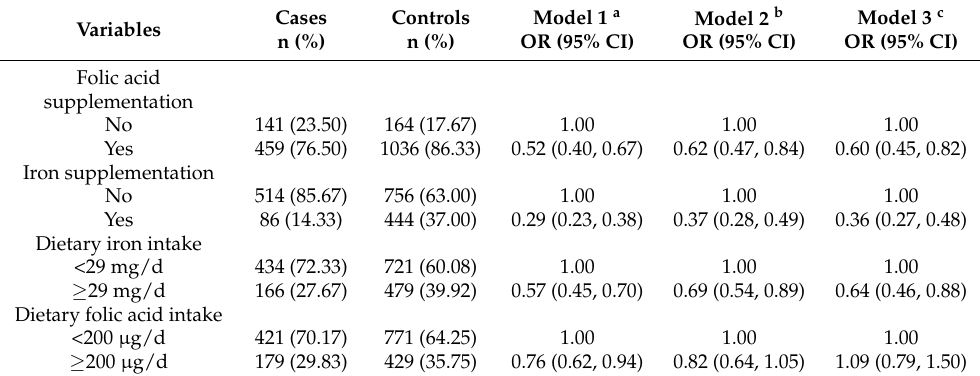
Table 2. The association of maternal folic acid and iron nutrition during pregnancy with CHD.